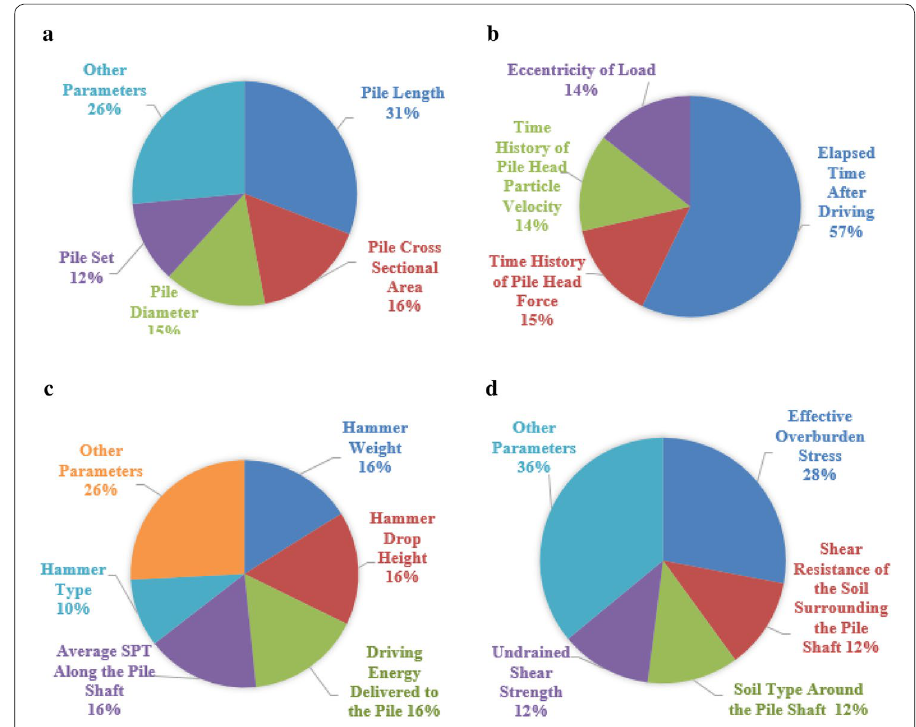
Fig. 5 Percentage of repeat of input variables in ANN applications for ( a ) pile properties, ( b ) loading history, ( c ) hammer/SPT/CPT information, and ( d ) soil properties